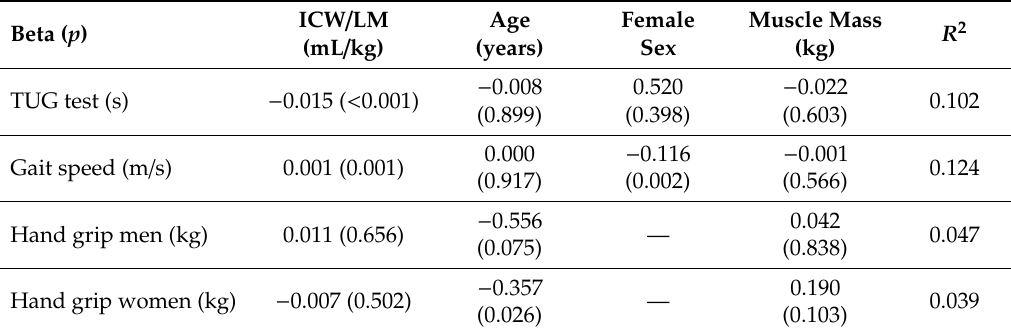
Table 3. E ff ect of the intracellular water / lean mass (ICW / LM) ratio on di ff erent functional outcomes (timed up-and-go (TUG) test, gait speed and hand grip) adjusted for age, sex and muscle mass (multivariate linear regression analyses).